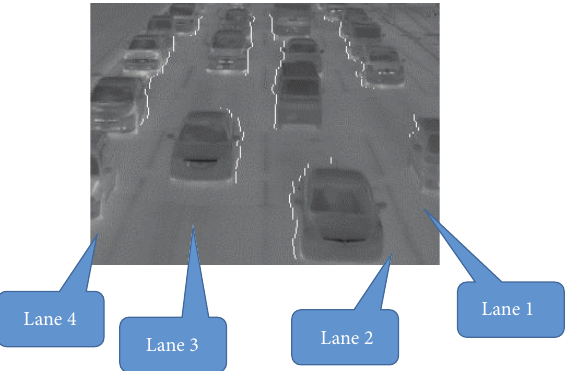
Figure 9: Detected edges of left and right sides of vehicles.